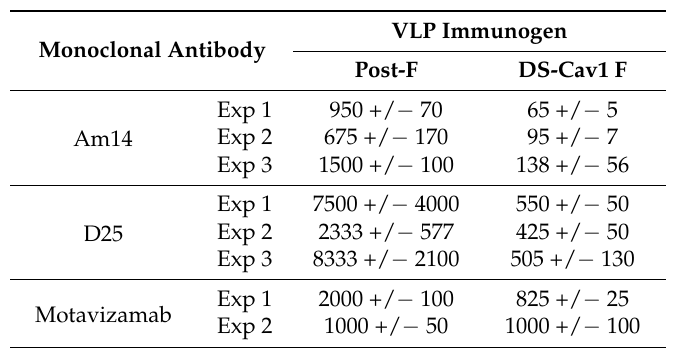
somewhat above 2000 ng/mL indicate sera that only very weakly blocked binding. Values at or above 2000 ng/mL were quite variable from experiment to experiment, as indicated by the large standard